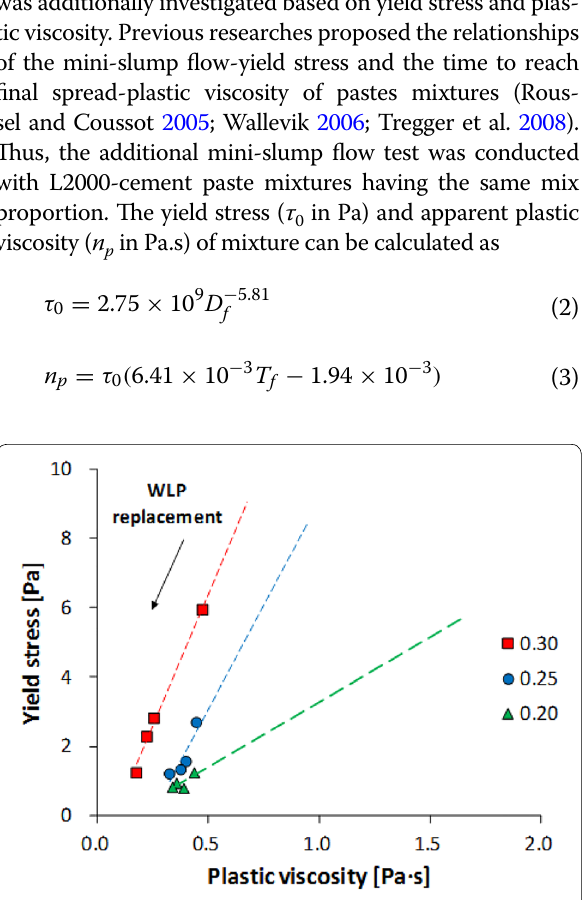
Fig. 6 Correlation of plastic viscosity and yield stress with WLP replaced mixtures (regarding L2000